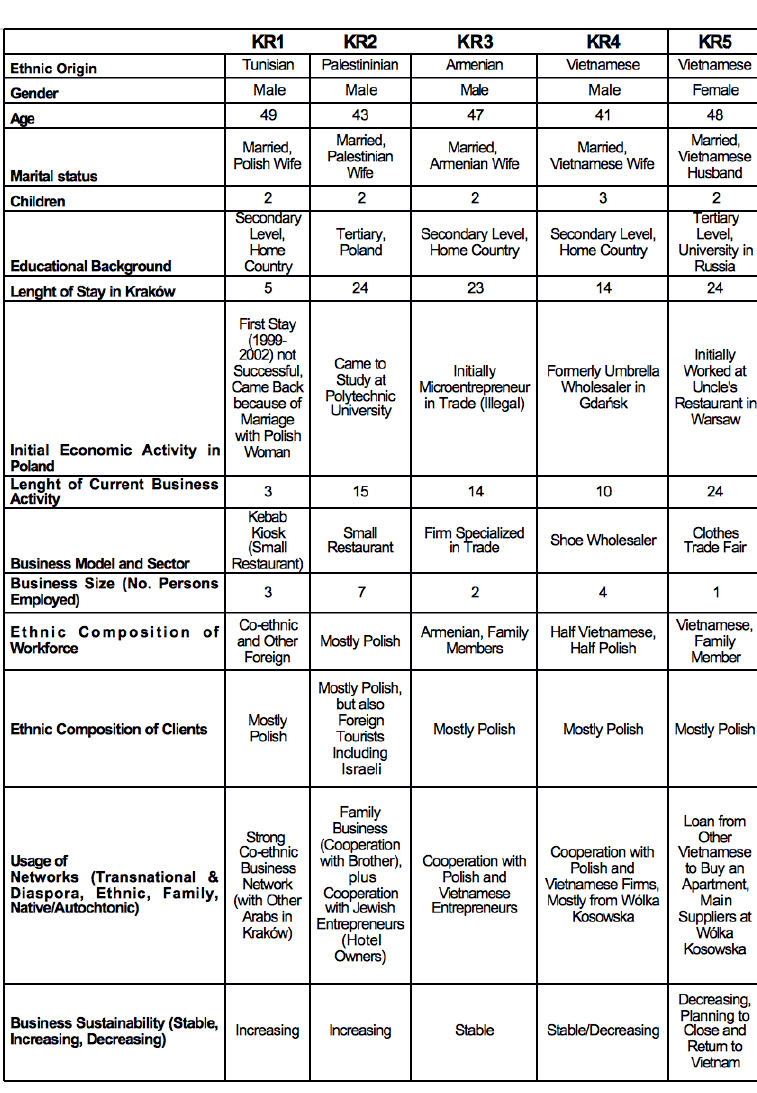
Table 1: Migrant Entrepreneurs in